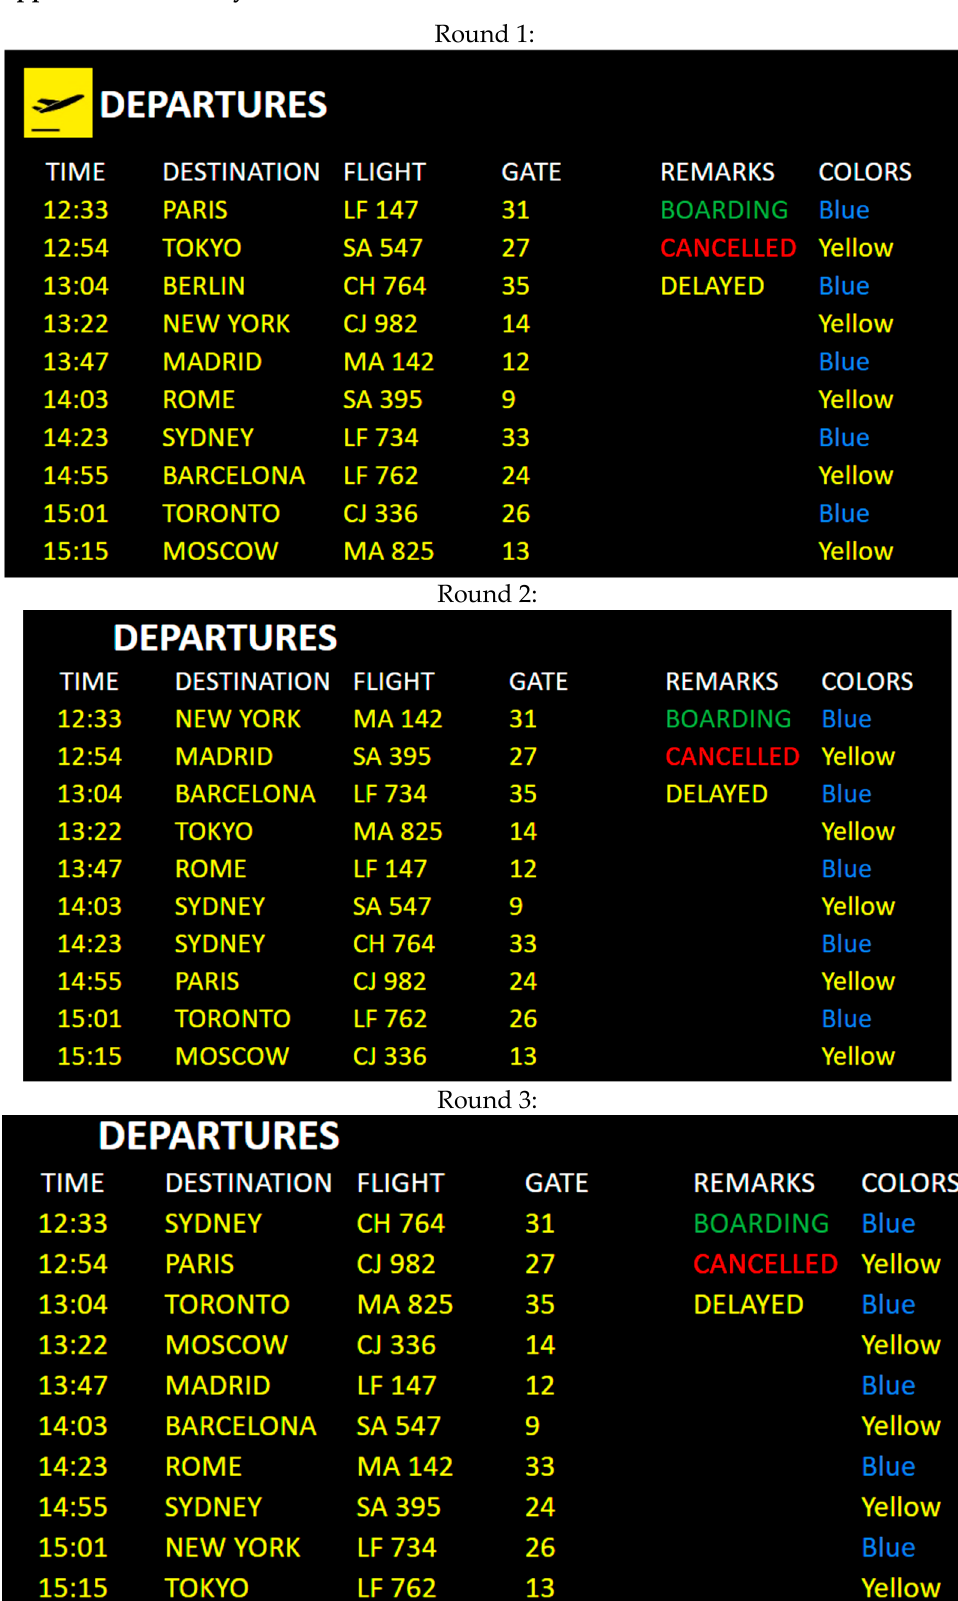
Figure A2. Paper plane specific drawings.